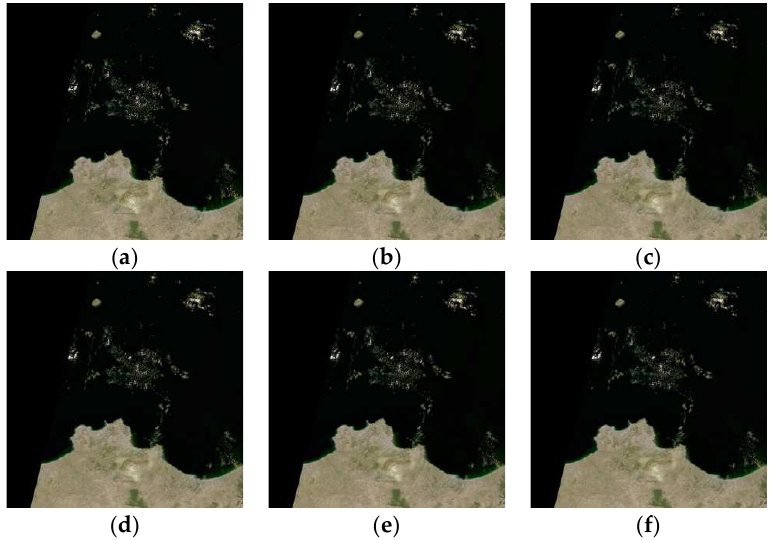
Figure 4. Source image and reconstructed images. ( a ) Source image; ( b ) reconstructed using MFTR; ( c ) reconstructed image (T = 6); ( d ) reconstructed image (T = 6); ( e ) reconstructed image (T = 20); ( f ) reconstructed image (T = 30).